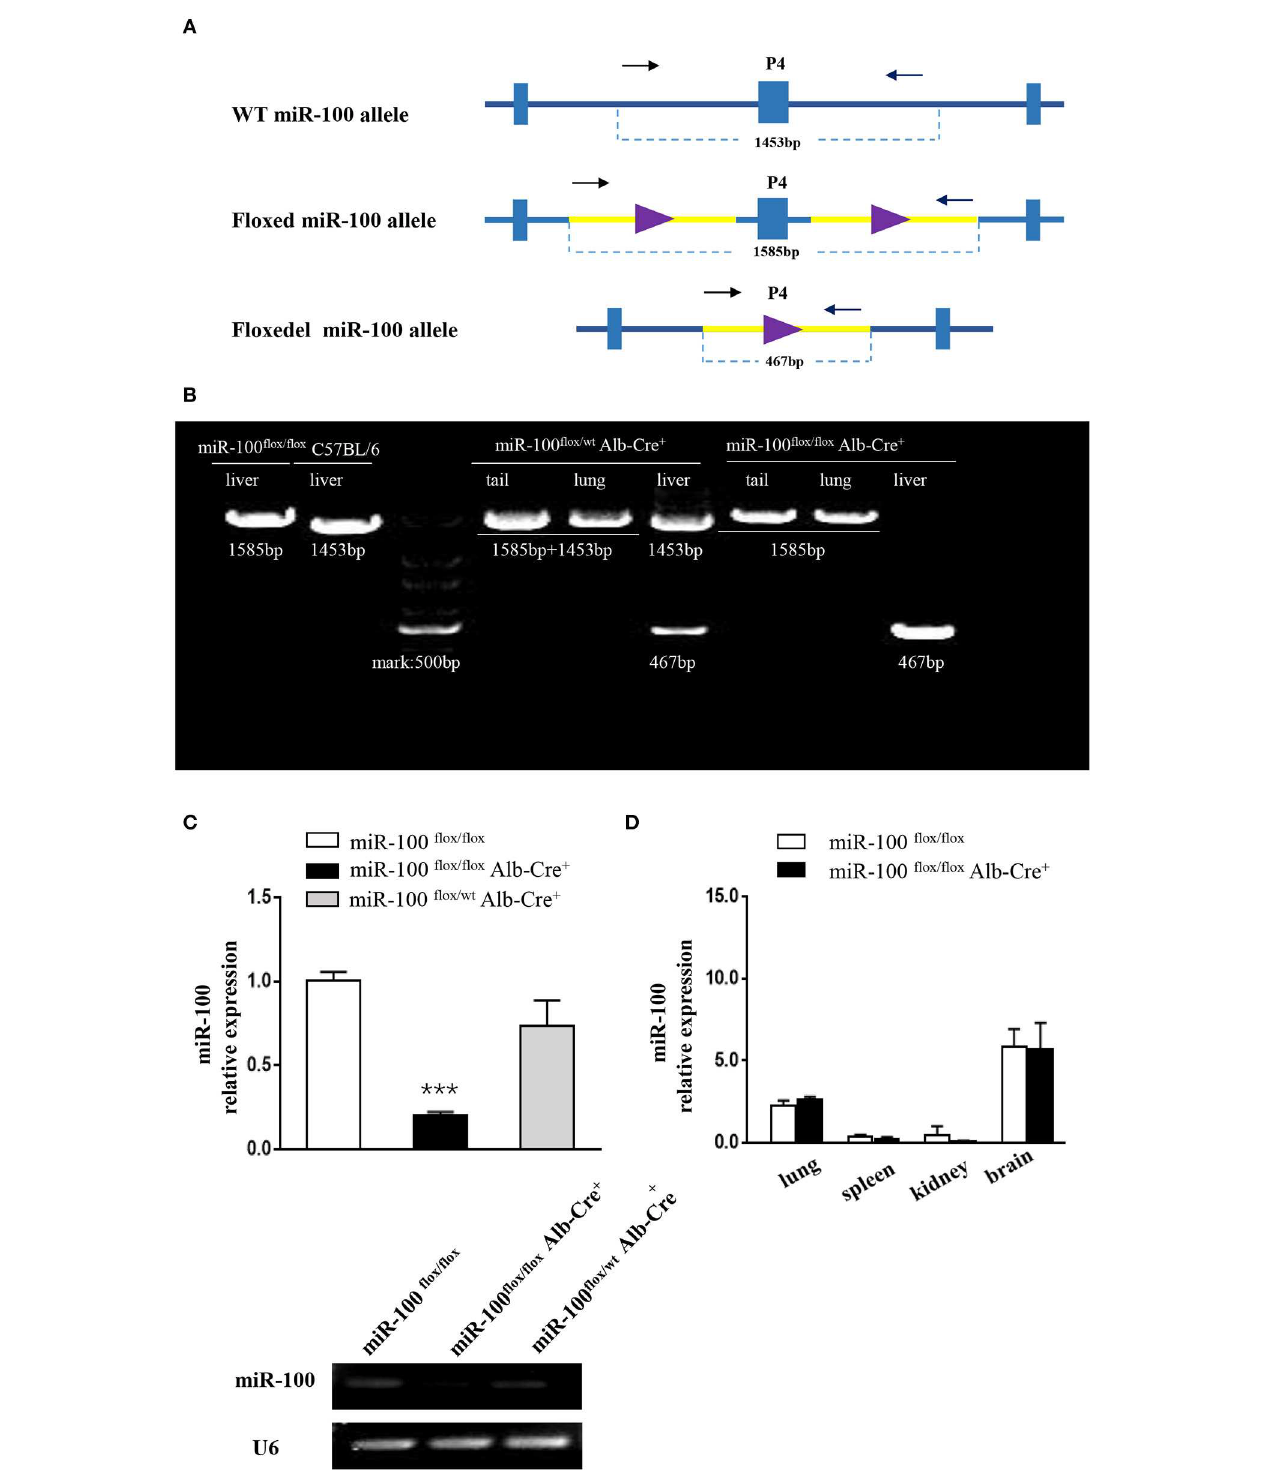
FIGURE 3 | Validation of liver-specific knockout mir-100 in miR-100 flox / flox Alb-Cre + mice. (A) Strategy for genotyping of miR-100 floxdel allele in the livers. Primers designed for amplifying either the wild type (1,453 bp) or the floxed (1,585 bp) and knockout (i.e., miR-100 floxdel, 467 bp) miR-100 allele. (B) Examples of genotyping are shown for the miR-100 floxdel allele. Genomic DNA was collected from tails, lungs, and livers from indicated mice, and amplified using P4 primers. Fragments for